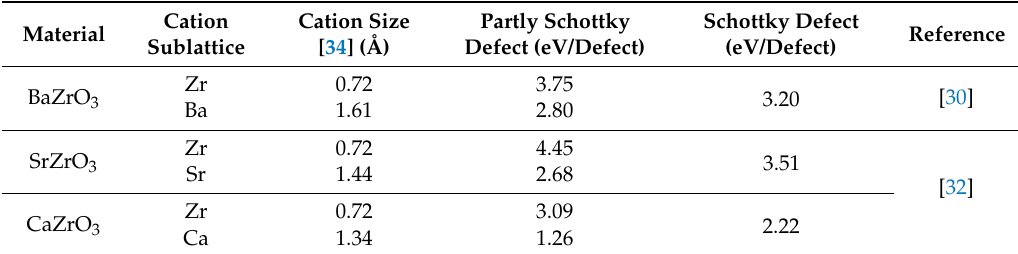
Table 3. The energy of formation of point defects in BZ, SZ, and CZ according to Equation (5) and (6), taken from the